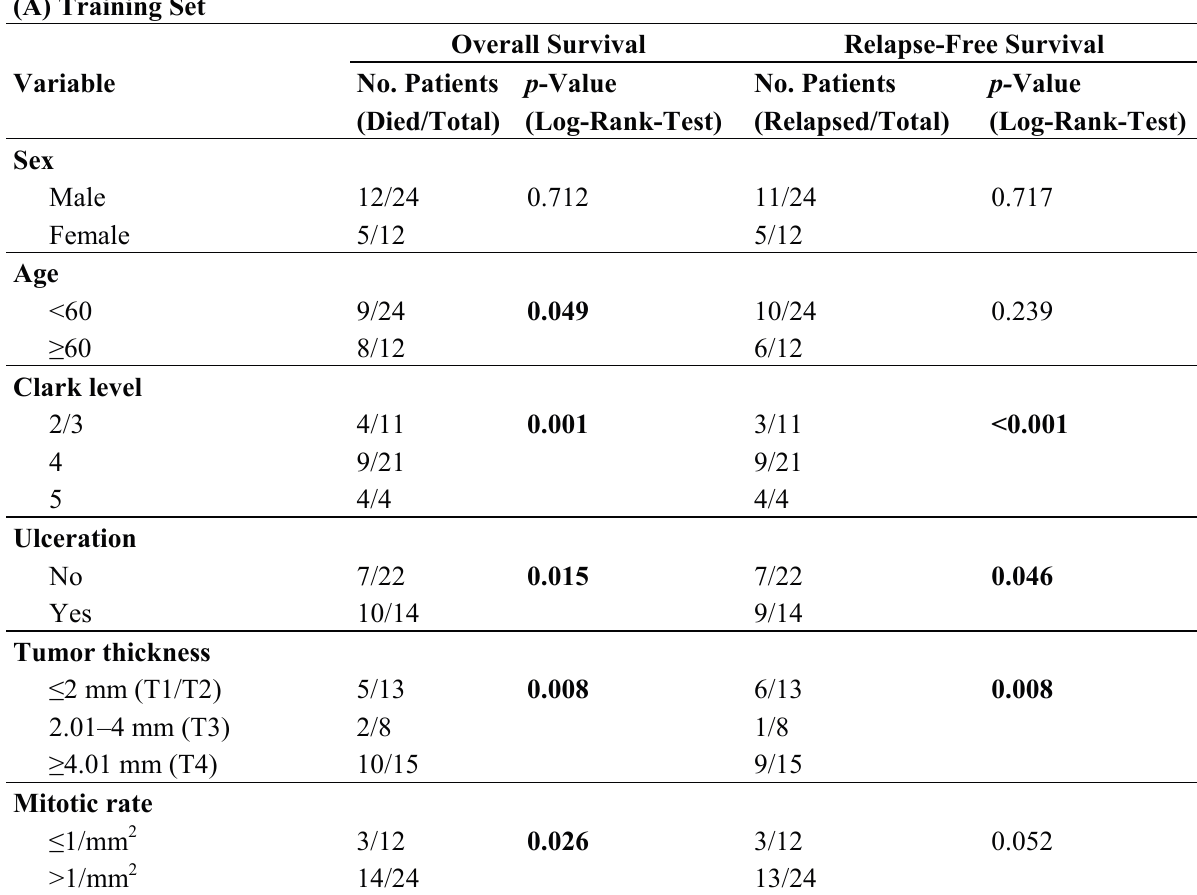
Table 1. Univariate survival analysis in melanoma patients. ( A ) Training set; ( B ) Test